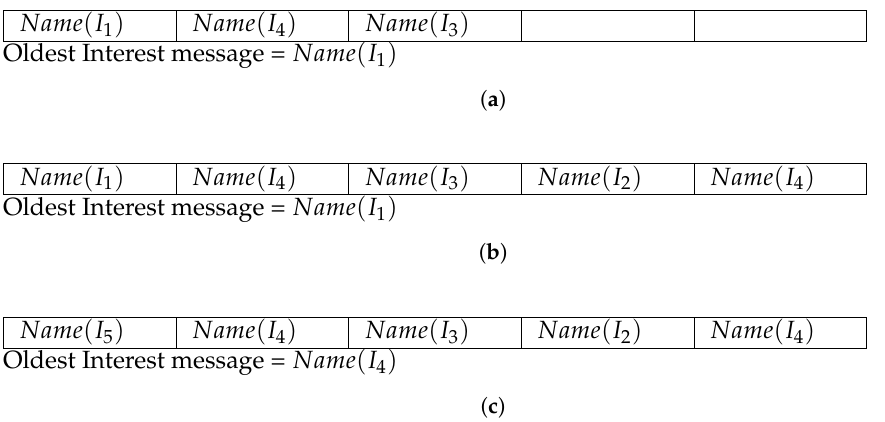
Figure 2. An illustration of the management of Interest message information in the Popularity Table. | ) = 5, | PT | = 3; ( b ) Max ( | PT ( a ) Max ( | PT R R i i | ) = 5, | PT | = 5 (after arrival of I Max ( | PT R R i i